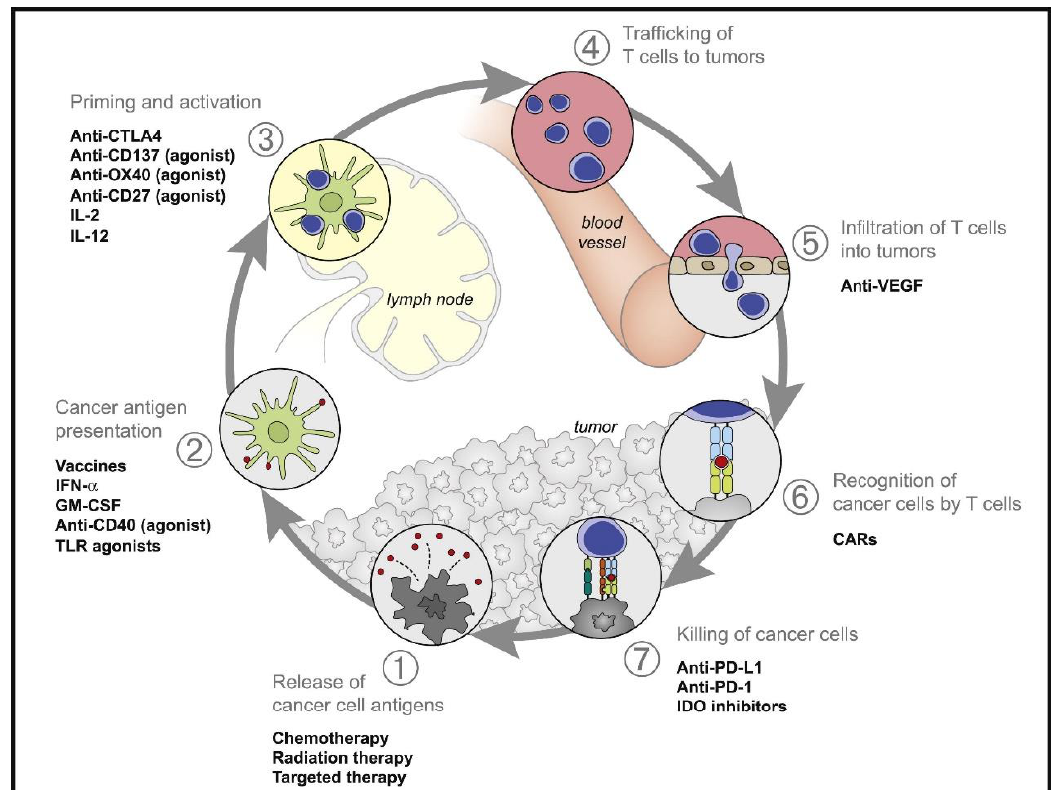
Figure 1. Schematic diagram of the tumor immune cycle. Stimulating and inhibiting factors in the immune cycle, and replacement therapy affecting the cycle [30].